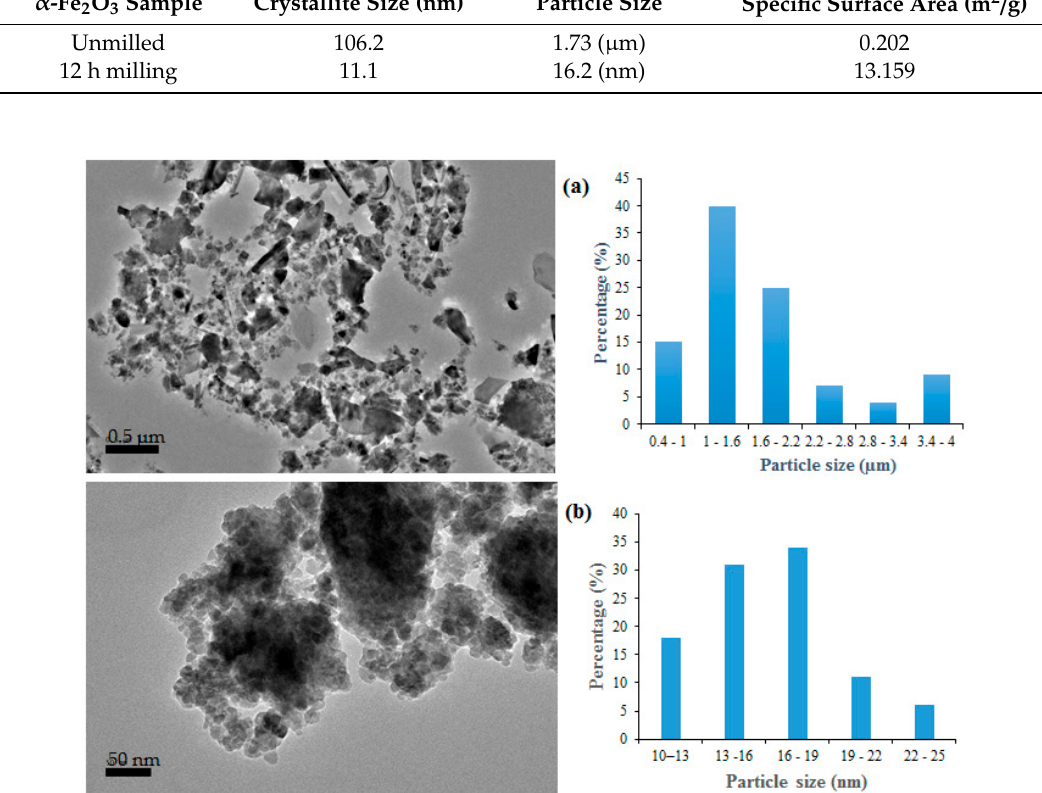
Figure 4. High-resolution transmission electron microscopy (HRTEM) micrographs and particle size distribution of α -Fe 2 O 3 ( a ) unmilled ( b ) nanoparticles.